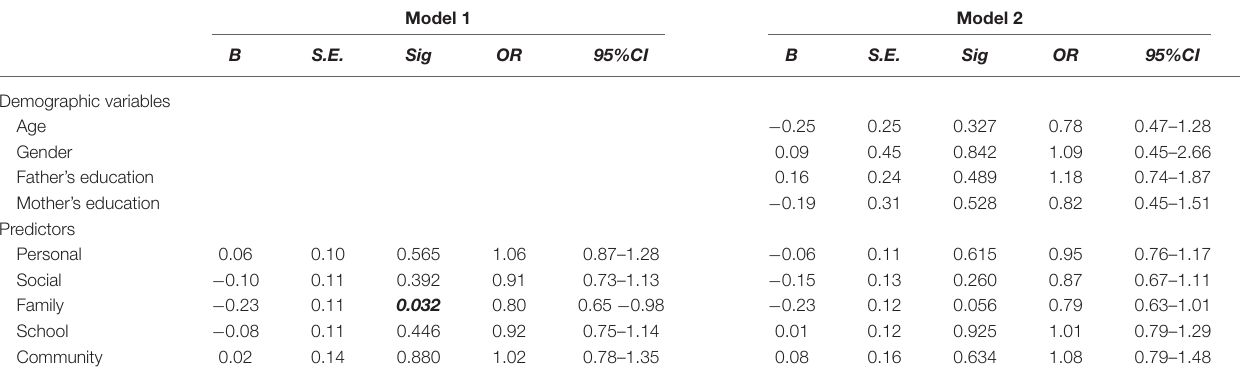
TABLE 5B | Associations between the five environmental asset categories and suicide attempt: logistic regression